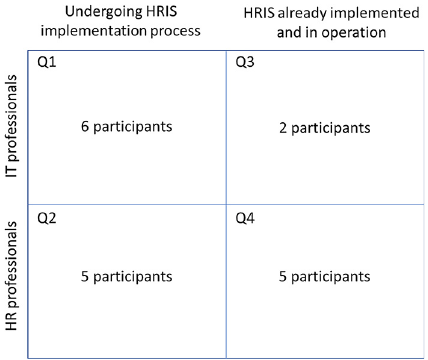
Figure 1. Comparison quadrants between professionals and